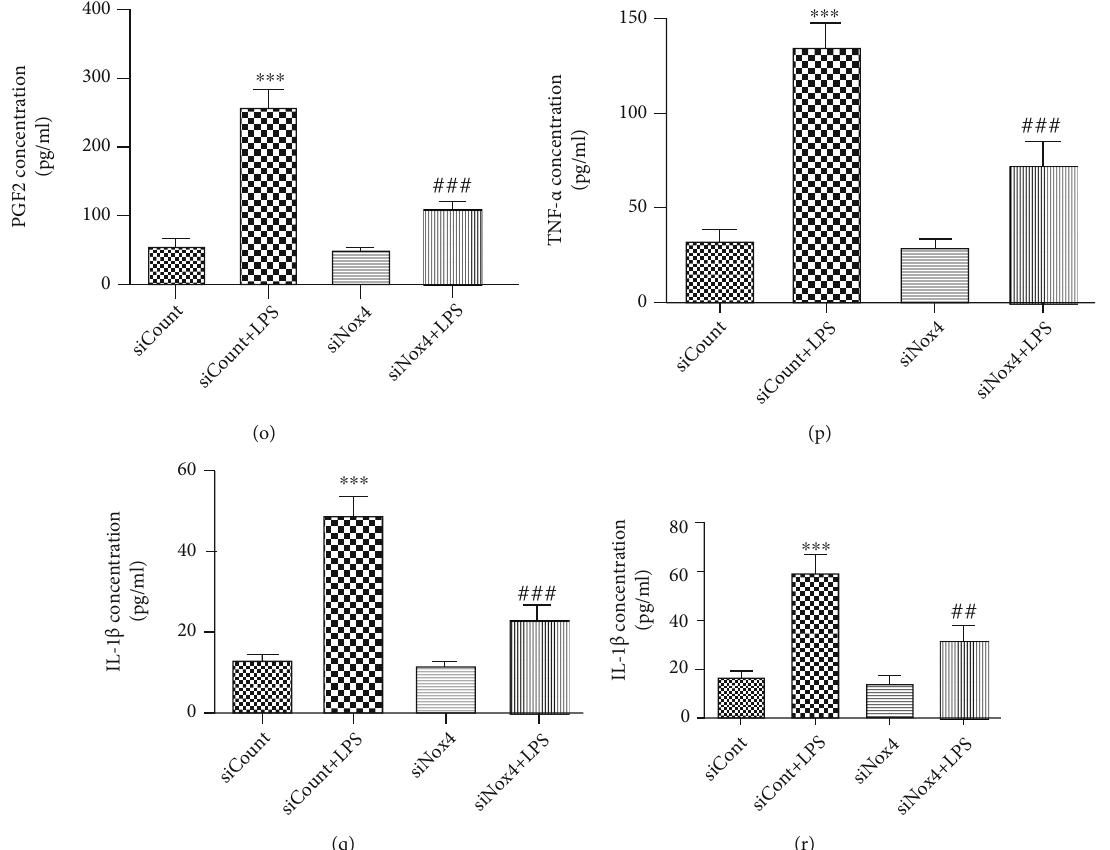
Figure 3: Nox4 is required for Poldip2 to exert action in response to LPS. (a, b) Con fl uent A549 and Beas-2B cells were transfected with siRNA for 72 h, and the e ffi ciency of Nox4 downregulation was veri fi ed by Western blotting and quantitatively analyzed. Following transfection, they were treated with LPS (10 μ g/mL for A549 cells and 1 μ g/mL for Beas-2B cells) for 12 h. (c, d) The protein levels of Poldip2, HO-1, and COX-2 were detected by Western blotting and quantitatively analyzed. (e – g, i) The expression of Poldip2 was detected by immuno fl uorescence analysis and laser confocal microscope. The cells were stained with Poldip2 (green) and counter stained with DAPI (blue) (magni fi cation of 400x). (h, j) The NADPH enzymatic activity in cells was detected by spectrophotometer. (k, l) The production of intracellular ROS was detected by fl ow cytometry. (m – r) The expression levels of PGE2, TNF- α , and IL-1 β in the supernatant were detected by ELISA. Bars are mean ± SD of 3 independent experiments. ns: not signi fi cant, ∗∗∗ P < 0 : 001 vs. siCont, ∗∗ P < 0 : 01 vs. siCont, ∗ P < 0 : 05 vs. siCont, ### P < 0 : 001 vs. siCont + LPS , ## P < 0 : 01 vs. siCont + LPS , and # P < 0 : 05 vs. siCont + LPS